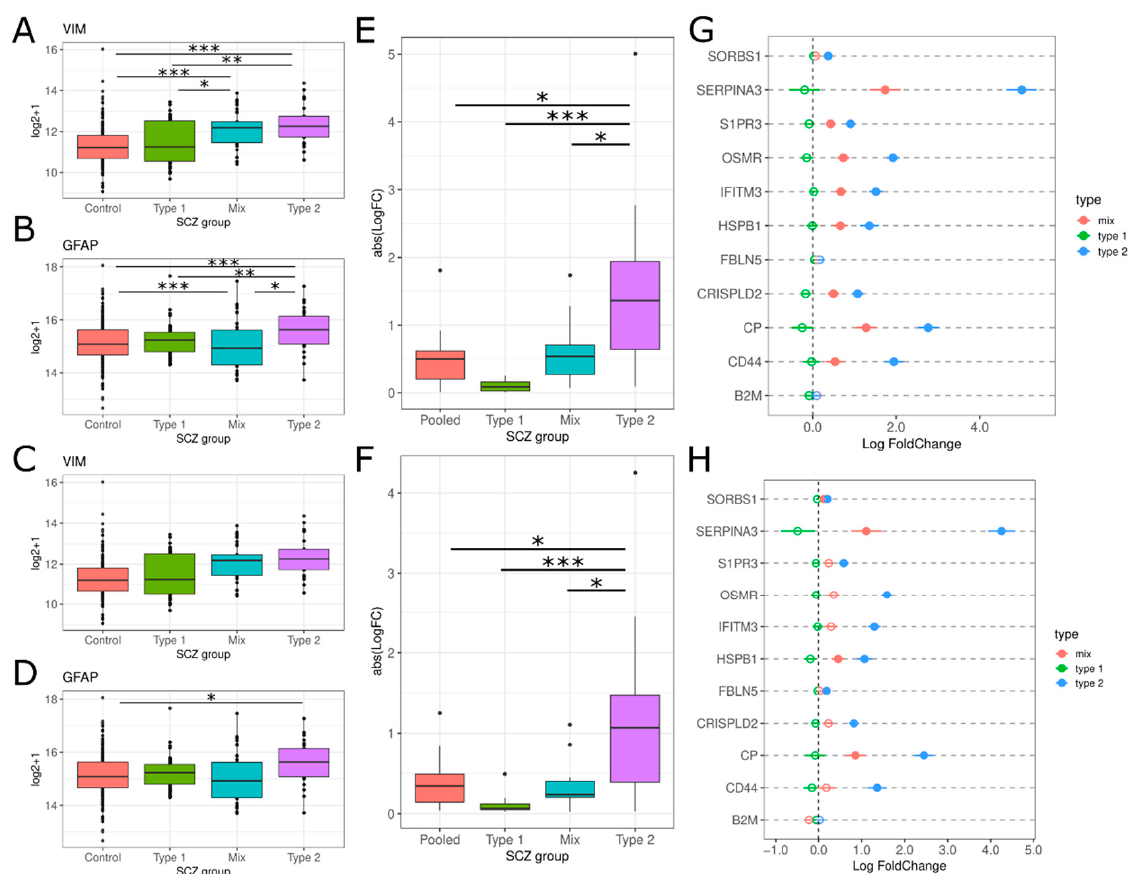
Figure 6. Astrocyte marker expression in the SCZ groups. ( A – D ) Boxplot of the log2+1 expression data is shown for each SCZ group: Controls (red), Type 1 (green), Mix (blue) and Type 2 (purple). ( A , B ) are from the polyA dataset, ( C , D ) for riboZ. * p -value < 0.05, ** p -value < 0.01, *** p -value < 0.001 via Tukey HSD. ( E , F ) Absolute LogFC value for astrocyte activation genes for each SCZ group for polyA and riboZ, respectively. * p -value < 0.05, *** p -value < 0.001 via Tukey HSD. ( G , H ) LogFC for genes associated with astrocyte activation across SCZ groups for polyA and riboZ, respectively: Type 2 (blue), Mix (red), Type 1 (green). Lines indicate standard error. Filled circles = differentially expressed (Benjamini-Hochberg p -value < 0.05), empty circles = not differentially expressed.